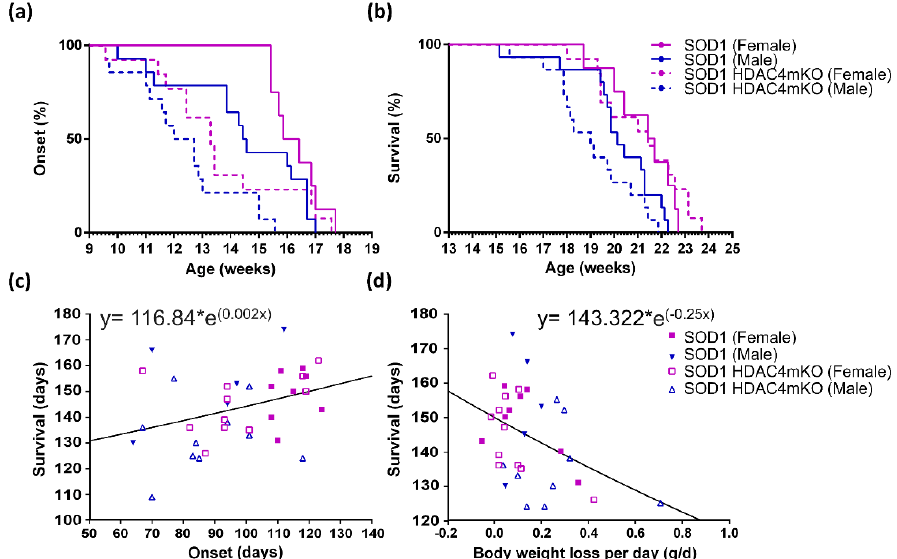
Figure 2. Sex and HDAC4 differentially affect the onset and lifespan of female and male SOD1 mice. ( a ) Age of ALS onset of female and male SOD1 and SOD1 HDAC4mKO mice. n = 12 females and n = 14 males for each genotype. p = 0.001 for global effect, p = 0.008 for sex, and p = 0.002 for genotype by Cox regression test. ( b ) Survival curve of SOD1 and SOD1 HDAC4mKO mice. n = 8 females and n = 14 males for each genotype; p = 0.001 for sex by Cox regression test. ( c ) Exponential curve correlating the lifespan and the time of ALS onset in female and male SOD1 and SOD1 HDAC4mKO mice. n = 34; R square = 0.131; p = 0.035. ( d ) Exponential curve correlating the lifespan and the velocity of body weight loss (g per day) in female and male SOD1 and SOD1 HDAC4mKO mice. n = 33, R square = 0.178; p = 0.015.